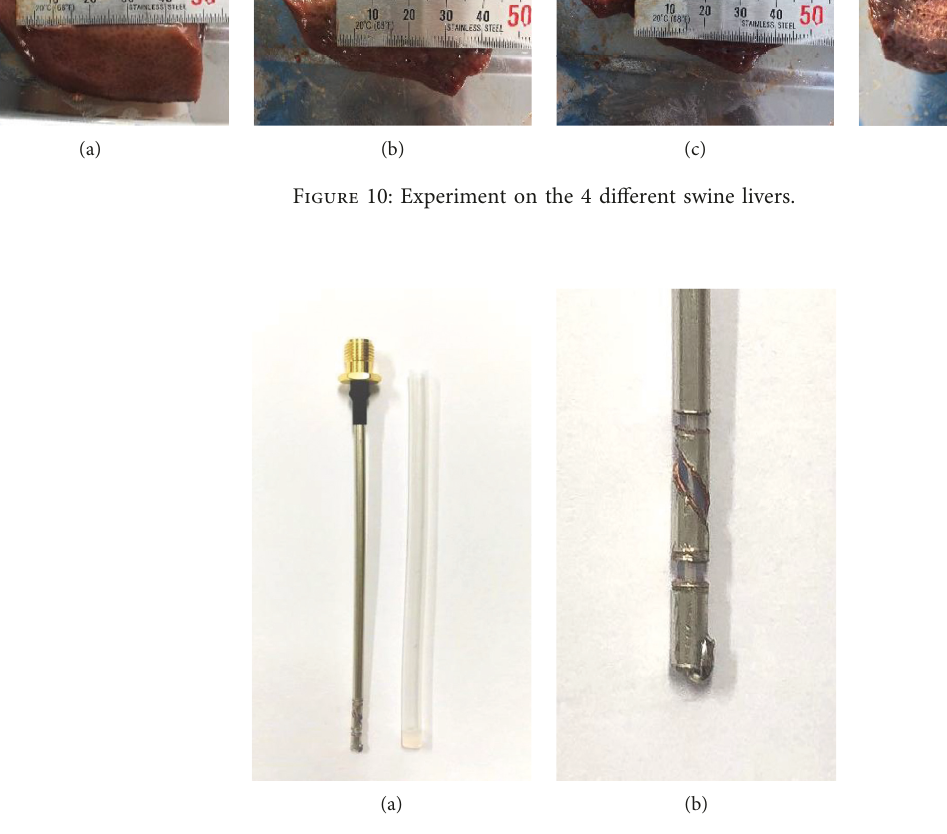
Figure 11: Views of (a) implemented antenna and (b) helical slot